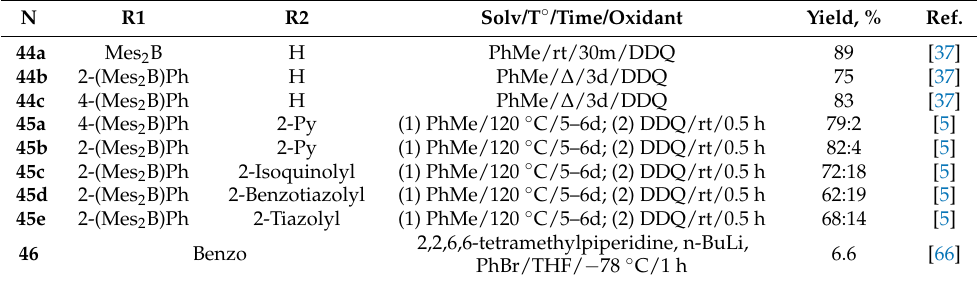
Table 11. Substituents and yields (ratio of isomers) of cycloaddition to benzoindolizines (Scheme 21).